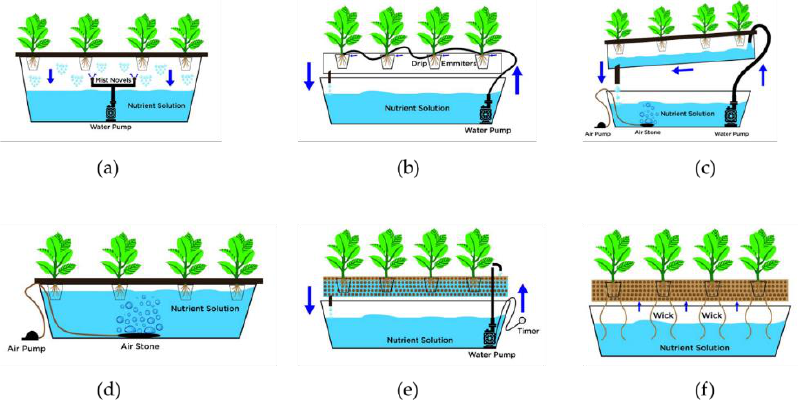
Figure 1. Common hydroponic systems: ( a ) aeroponics, ( b ) drip system, ( c ) nutrient film technique (NFT), ( d ) deep water culture, ( e ) ebb and flow and ( f ) wick system. The illustrations are sourced from The Hydroponics Guru. https://thehydroponicsguru.com/types-of-hydroponics-systems/ (Ac- cessed 12 October 2022) [97].